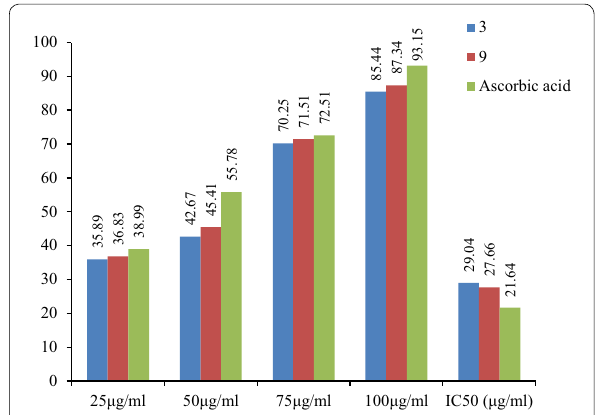
Fig. 6 Graph of potent antioxidant compound 3 and 9